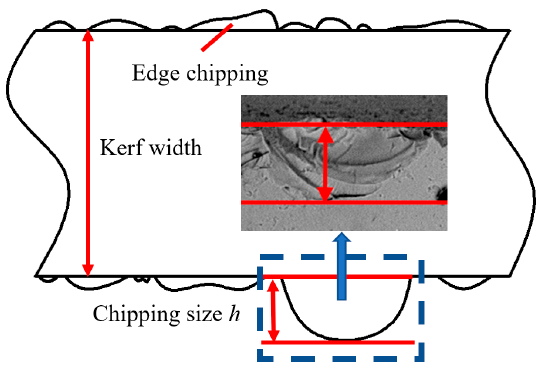
Figure 11. Measurement of edge chipping size.